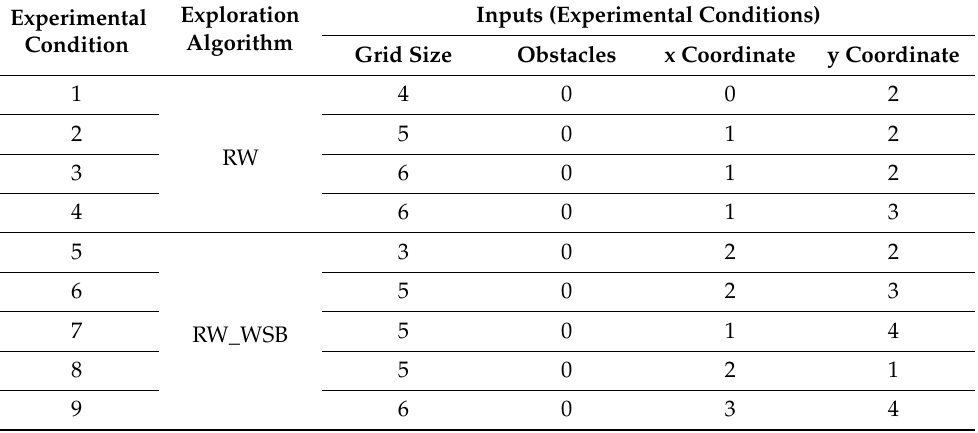
Table 3. Conditions for a final experimental test.